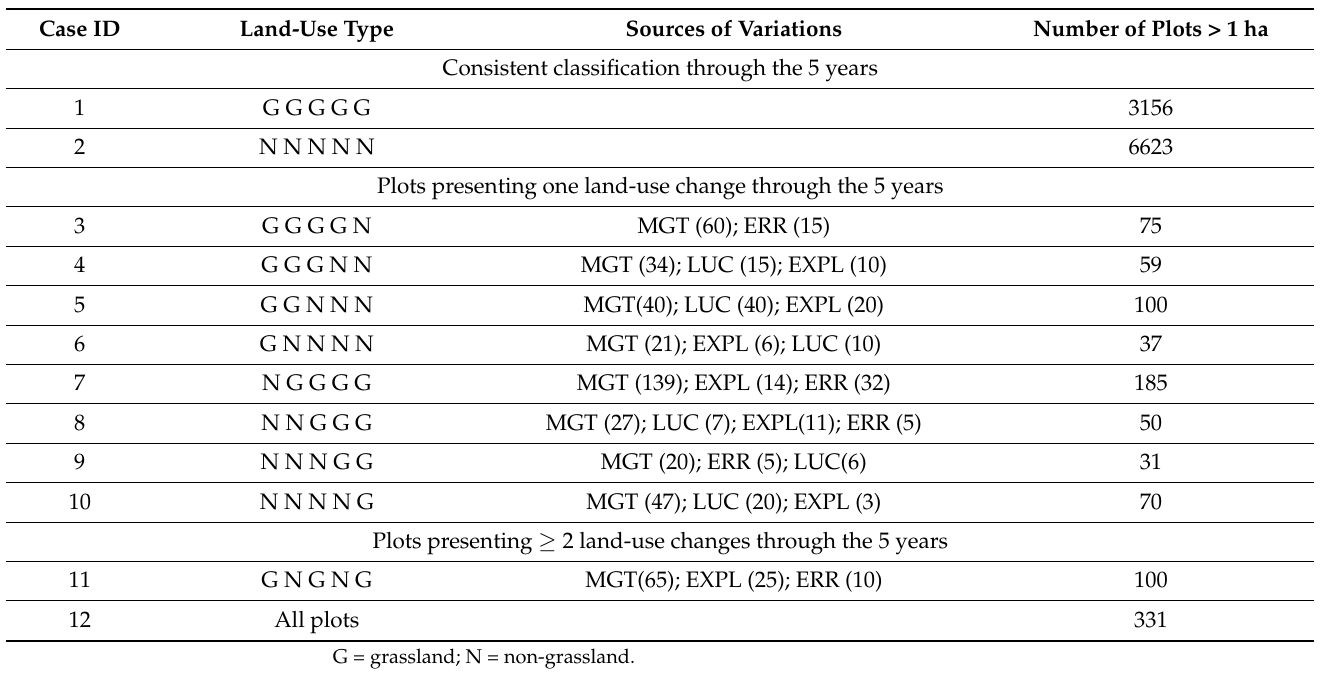
Table 6. Composition of land-use change classes. (The land-use type sequence corresponds to the five-year succession G and N corresponding to the IPG and NIG classes, respectively).